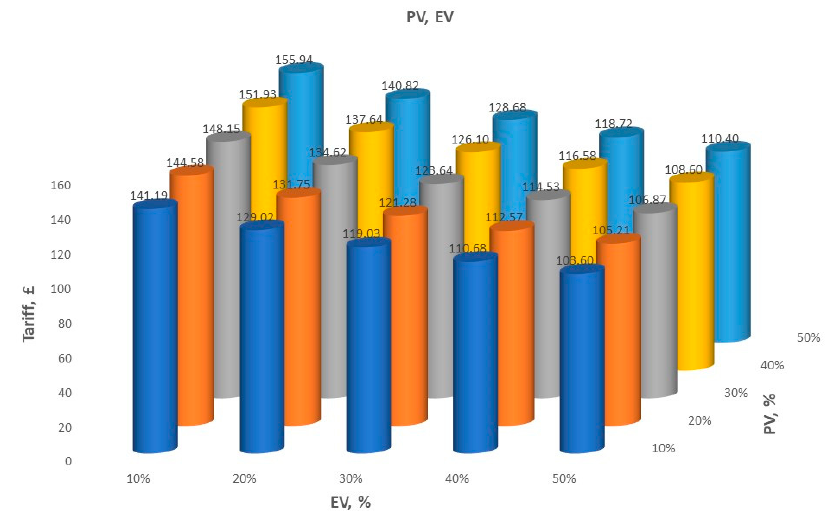
Figure 4. Distribution tariffs for households with PV and EV. Source: Own results